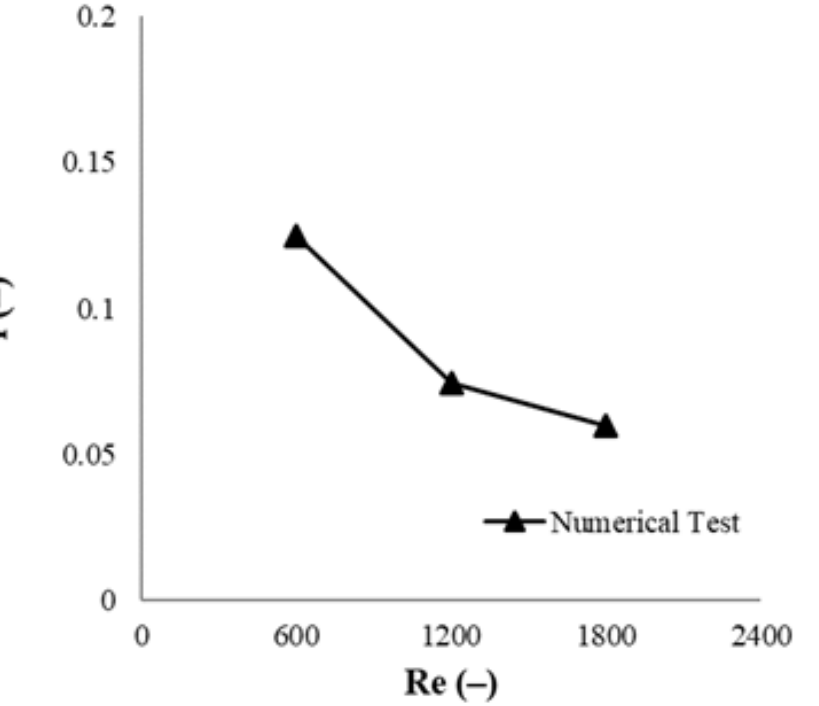
Figure 8. Comparison of friction factor values obtained by changing Reynolds numbers (pure wa ‐ ter).